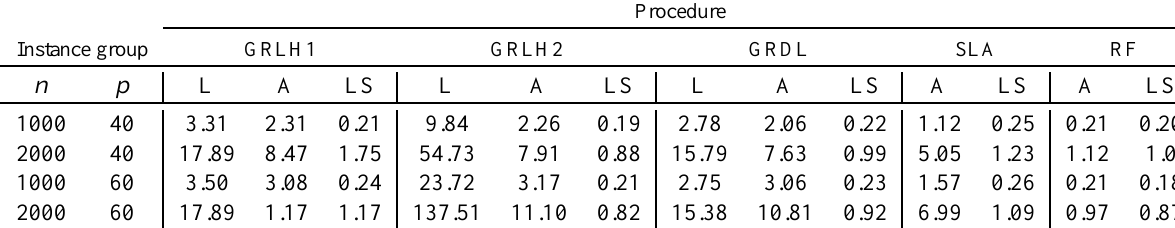
Table 11. Average time (sec) by phase.